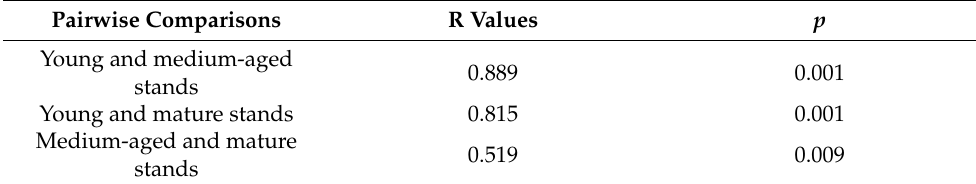
Table 3. ANOSIM pairwise comparisons of macrofungal composition between young, medium-aged, and mature Pinus radiata stands based on Bray–Curtis distance measures (global R-value = 0.74; p = 0.004). Pairwise Comparisons R Values p Young and medium-aged 0.889 0.001 stands Young and mature stands 0.815 0.001 Medium-aged and mature 0.519 stands